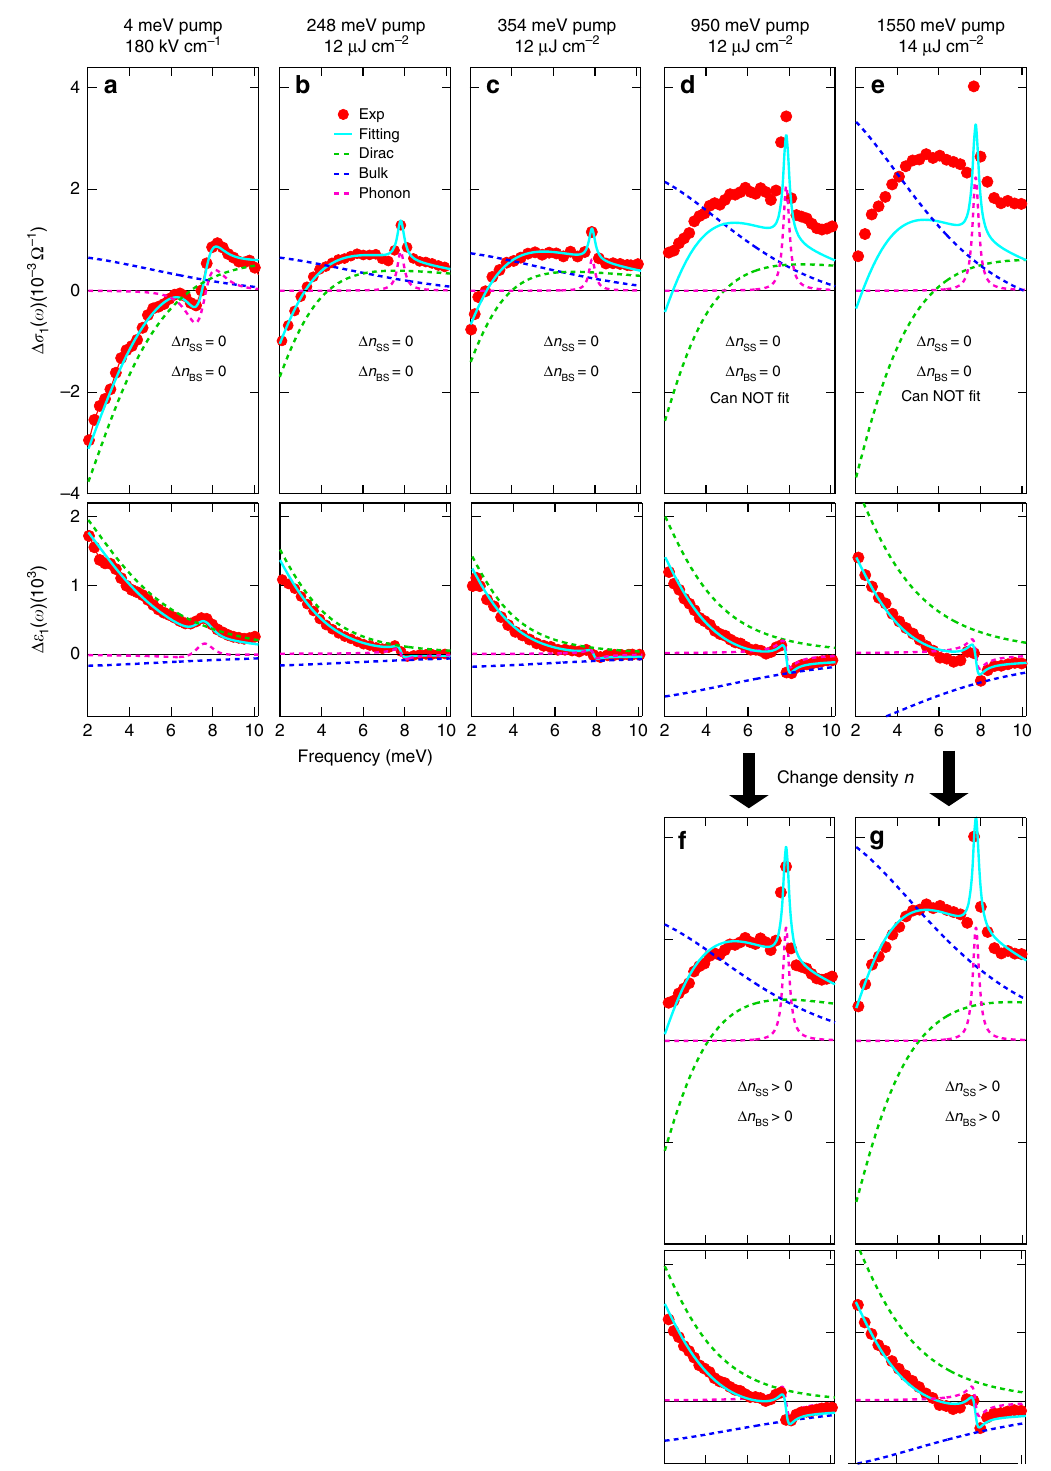
Fig. 5 Ultrafast THz spectra by wavelength-selective pump from THz to visible. THz spectra for several pump photon energies: a 4 meV, b 248 meV, c 354 meV, d – f 950 meV, and e , g 1550 meV at Δ t pp = 1 ps. Figures for Δ σ 1 and Δ ε 1 have the same x and y axis ranges, respectively, for fair comparison. The THz spectra for a 4 meV, b 248 meV, and c 354 meV pump can be fi tted well by keeping the SS and BS carrier densities constant ( Δ n SS = 0 and Δ n BS = 0) and only changing the scattering rates of SS and BS. However, the THz spectra cannot be fi tted in the same way for d 950 meV and e 1550 meV pump. Instead, they have to be fi tted by changing both the carrier densities ( Δ n SS > 0 and Δ n BS > 0) and the scattering rates of SS and BS, as shown in f and